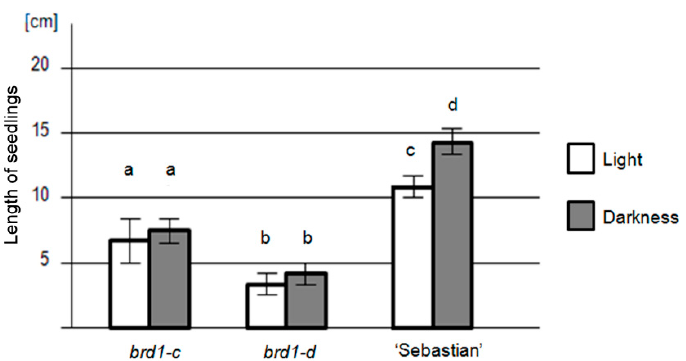
Int. J. Mol. Sci. 2016 , 17 , 600